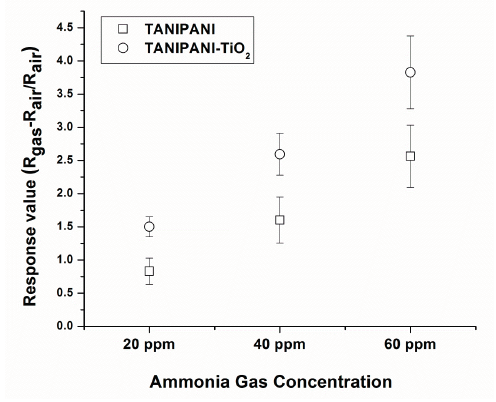
Figure 8. Response values of TANIPANI and TANIPANI-TiO 2 when exposed to 20 ppm, 40 ppm and 60 ppm of ammonia gas for a period of 60